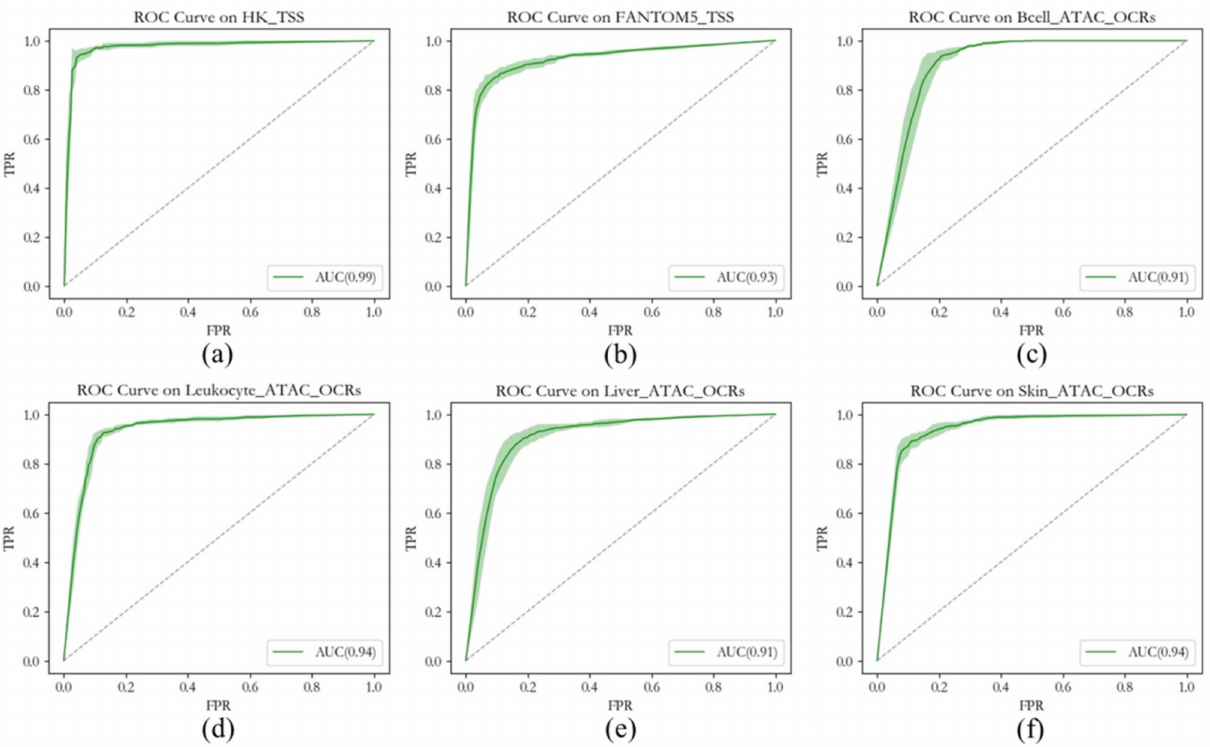
Figure 2. ROC curves of random forest classifiers using different test sets. ( a ) The ROC Curve of random forest classifiers using HK_TSS test set. ( b ) The ROC Curve of random forest classifiers using FANTOM5_TSS test set. ( c ) The ROC Curve of random forest classifiers using Bcell_ATAC_TSS test set. ( d ) The ROC Curve of random forest classifiers using Leukocyte_ATAC_TSS test set. ( e ) The ROC Curve of random forest classifiers using Liver_ATAC_TSS test set. ( f ) The ROC Curve of random forest classifiers using Skin_ATAC_TSS test